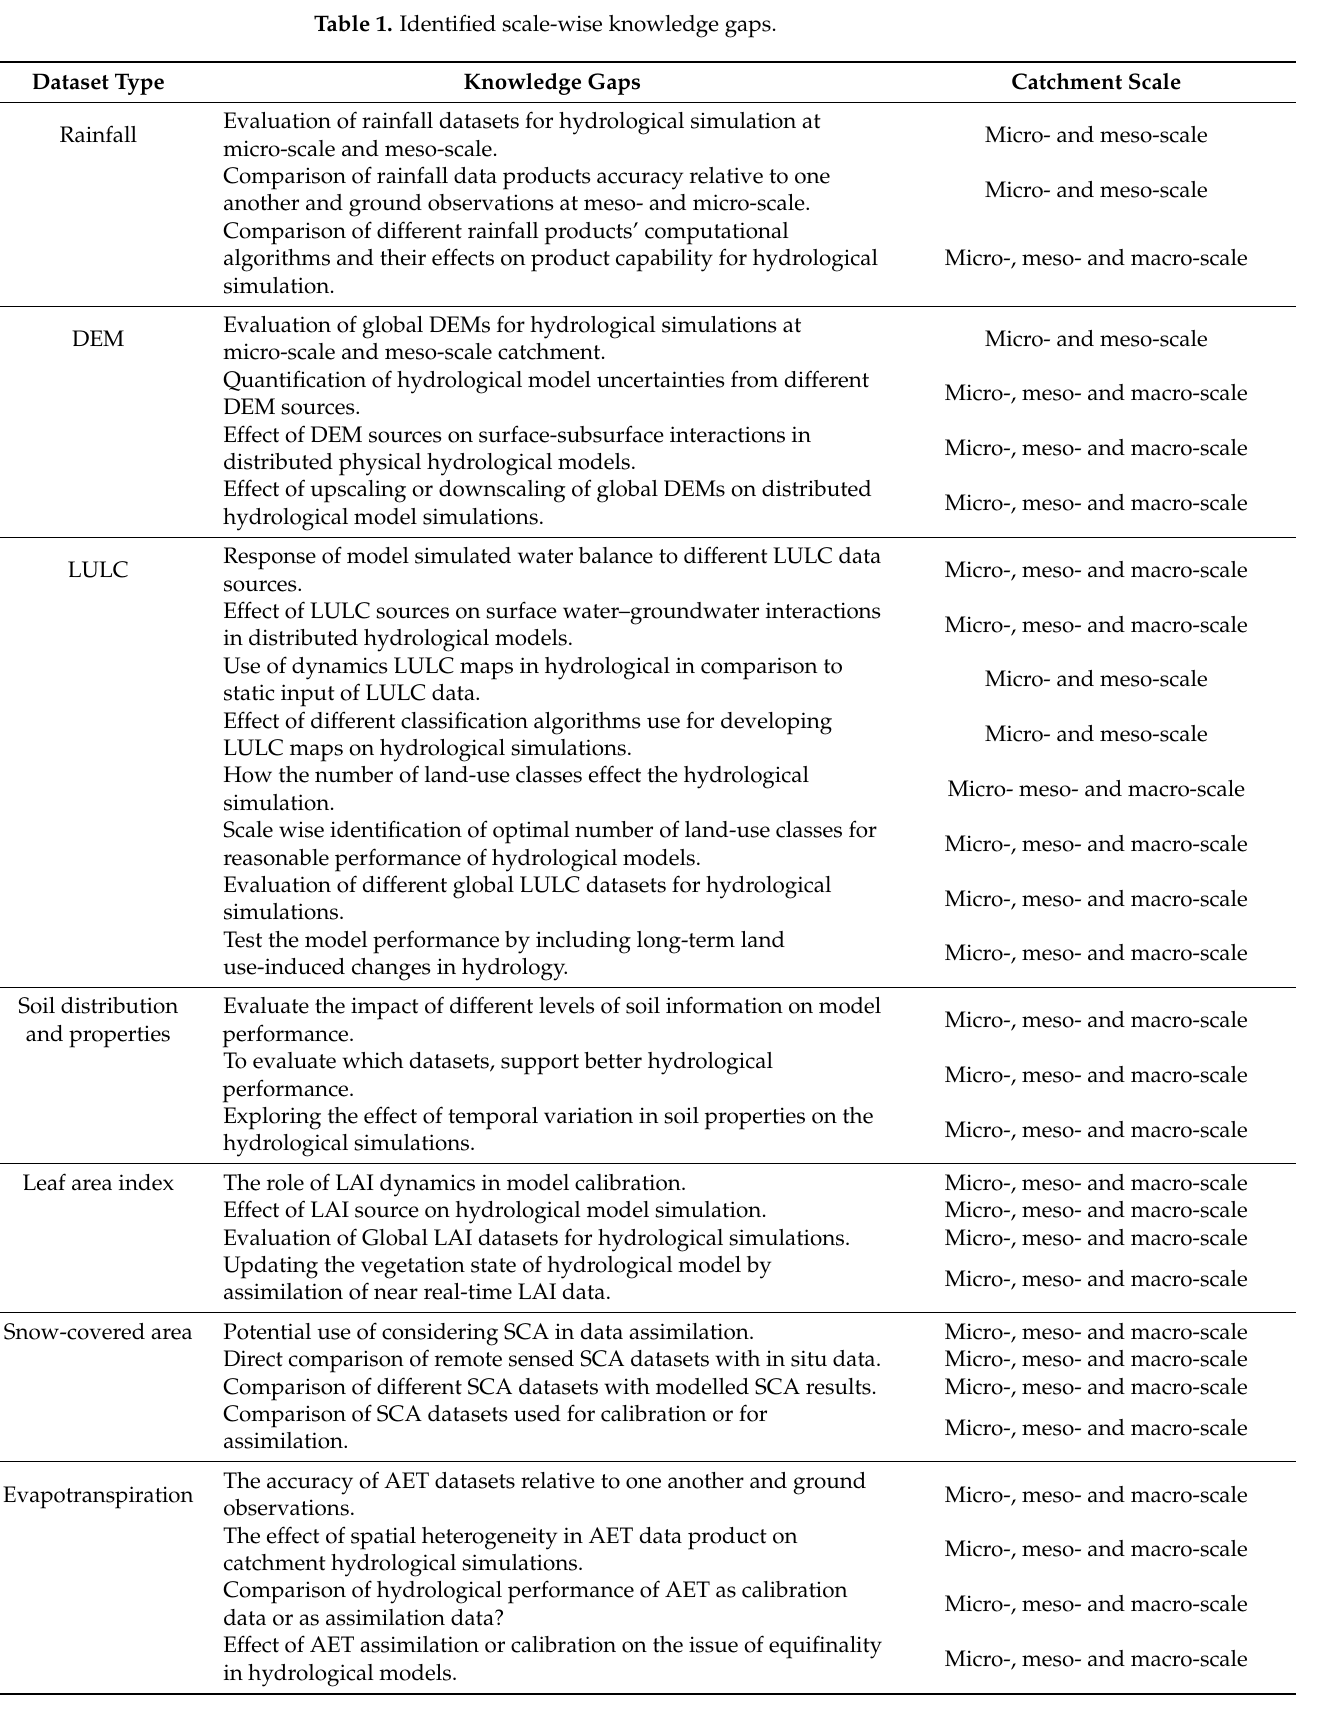
Table 1. Identified scale-wise knowledge